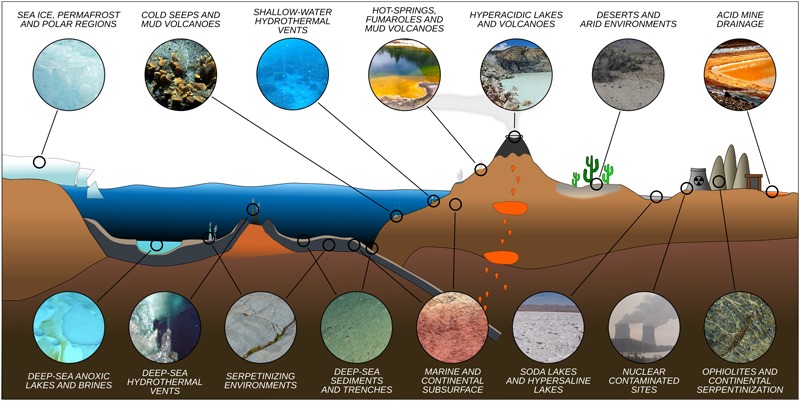
Representative idealized cross section of Earth’s crust showing the diversity of extreme environments and their approximate location.